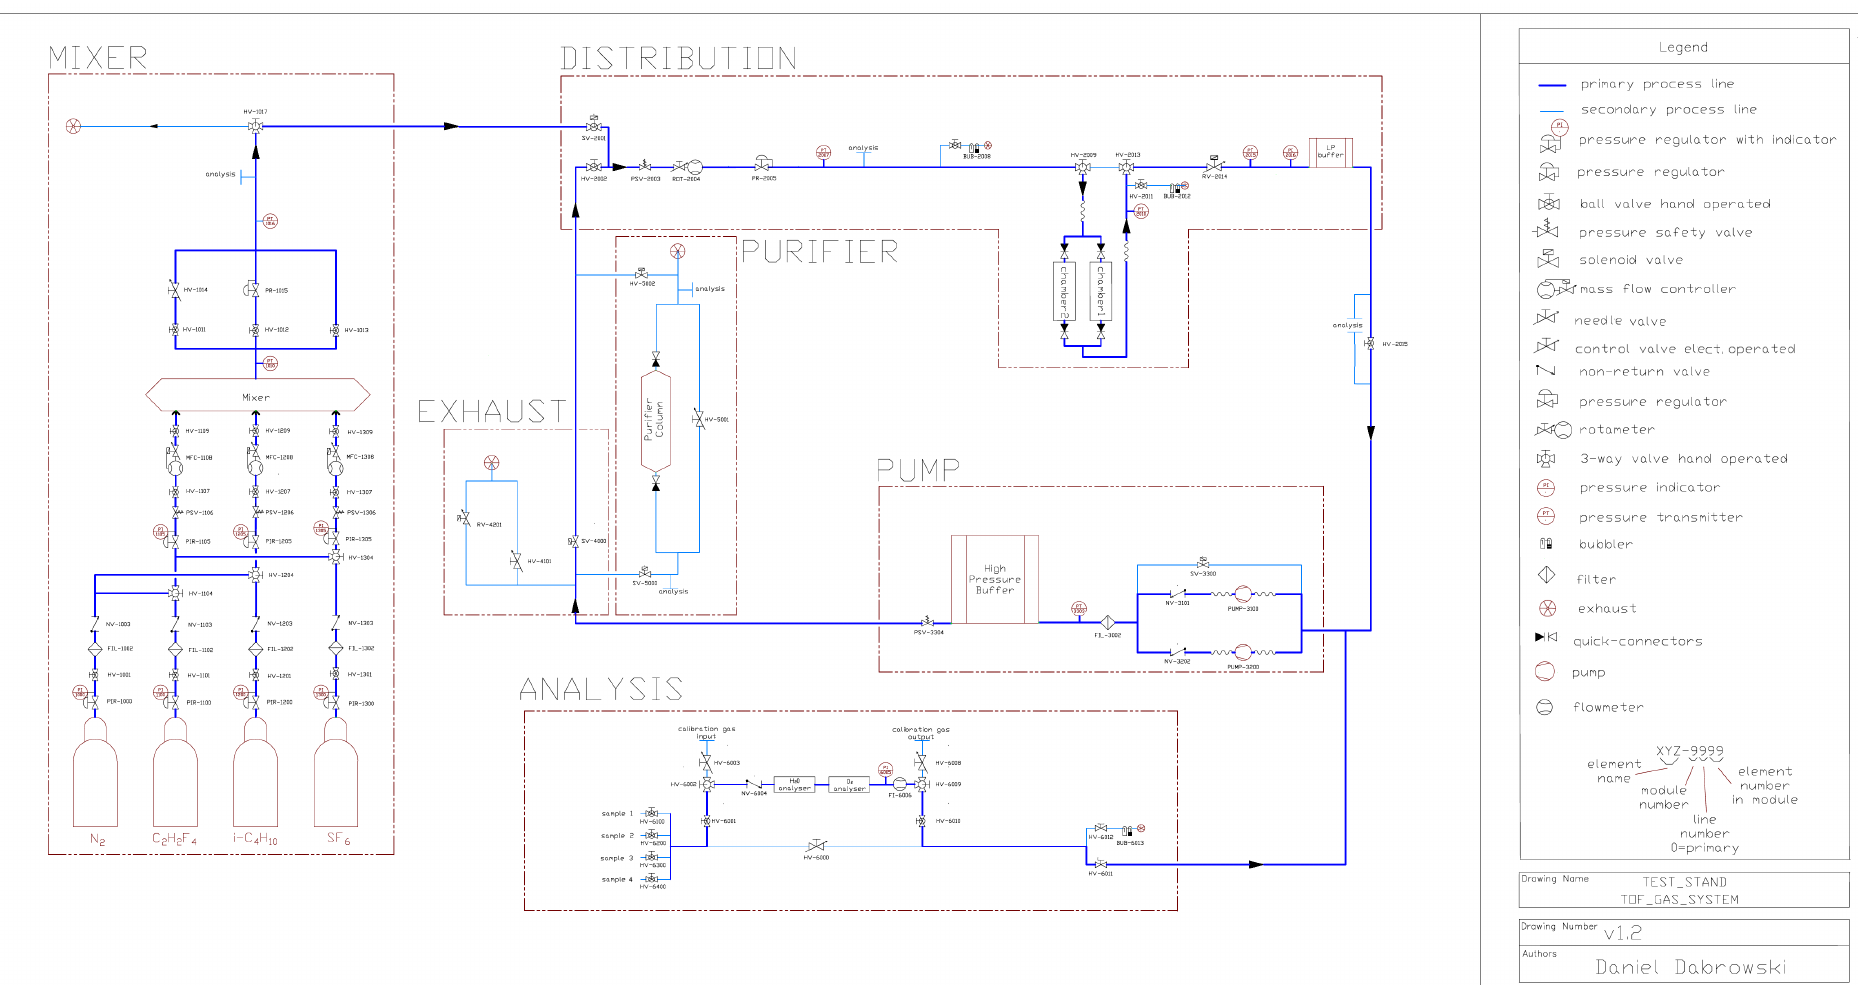
Figure 4. Gas system P&ID drawing—pilot